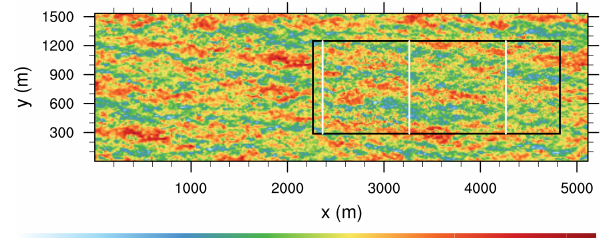
Figure 10. The 2h time-averaged and y -averaged horizontal pro- files of the friction velocity for the grid-spacing ratio of 2, 3, and 4, as well as the corresponding coarse and fine-grid reference simula-